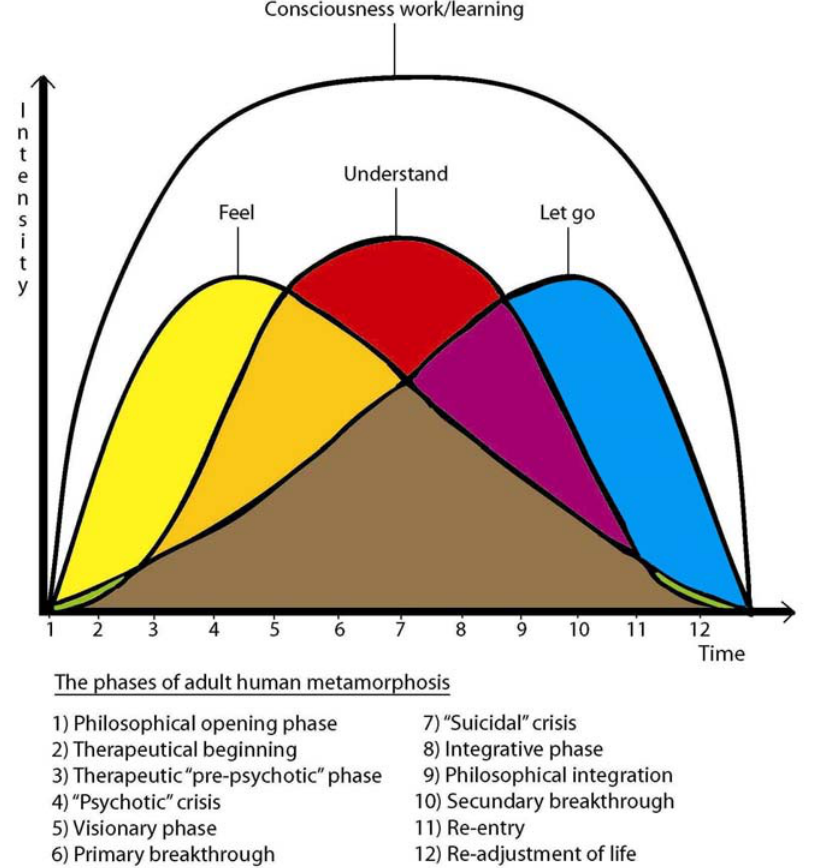
FIGURE 1 . The therapeutic arc of transformation. Please notice that there are three existential crises connected to the process of healing from schizophrenia: (1) loss of old, safe self, and survival mechanism (giving up the splitting), often (re)experienced by the patient as a psychic death (number 4) in the figure; (2) the visionary phase, often called the healing crisis and often experienced as “holy madness” by the patient (number 5 and 6); and (3) the most intense, existential crisis of “to be or not to be”, often experienced as a suicidal crisis by the patient (number 7), where the basic value of life is considered, and where the patient finally must choose life as it